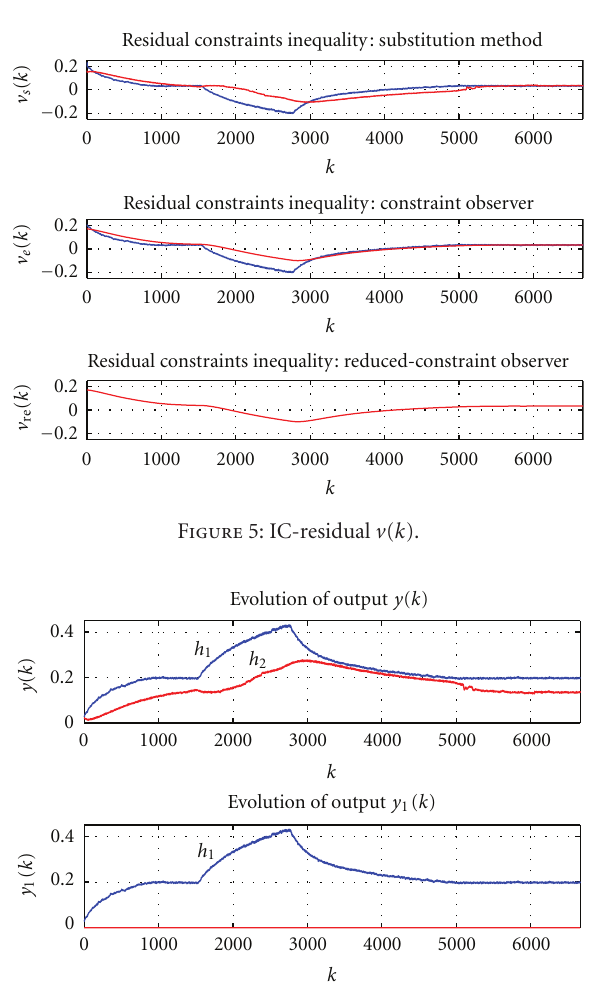
Figure 6: Water levels h 1 and h 2 in tanks R 1 and R 2